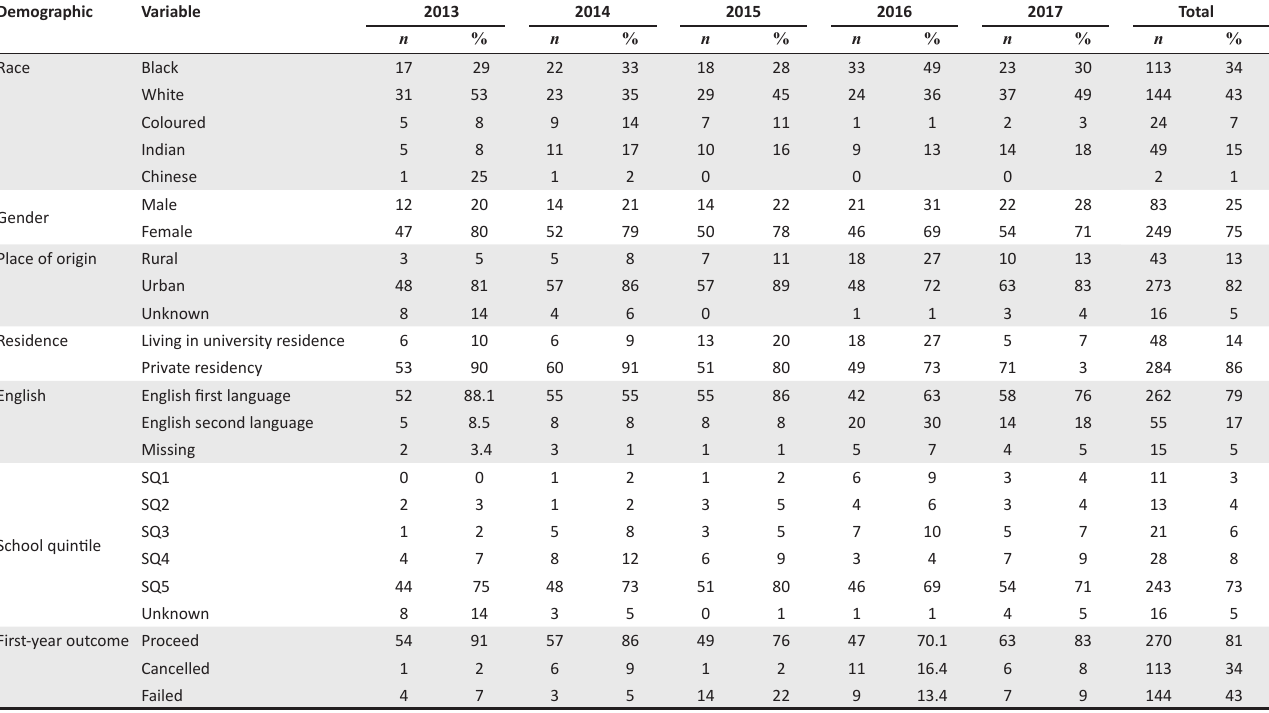
TABLE 2: Demographic profile of the student cohort (2013–2017). Demographic